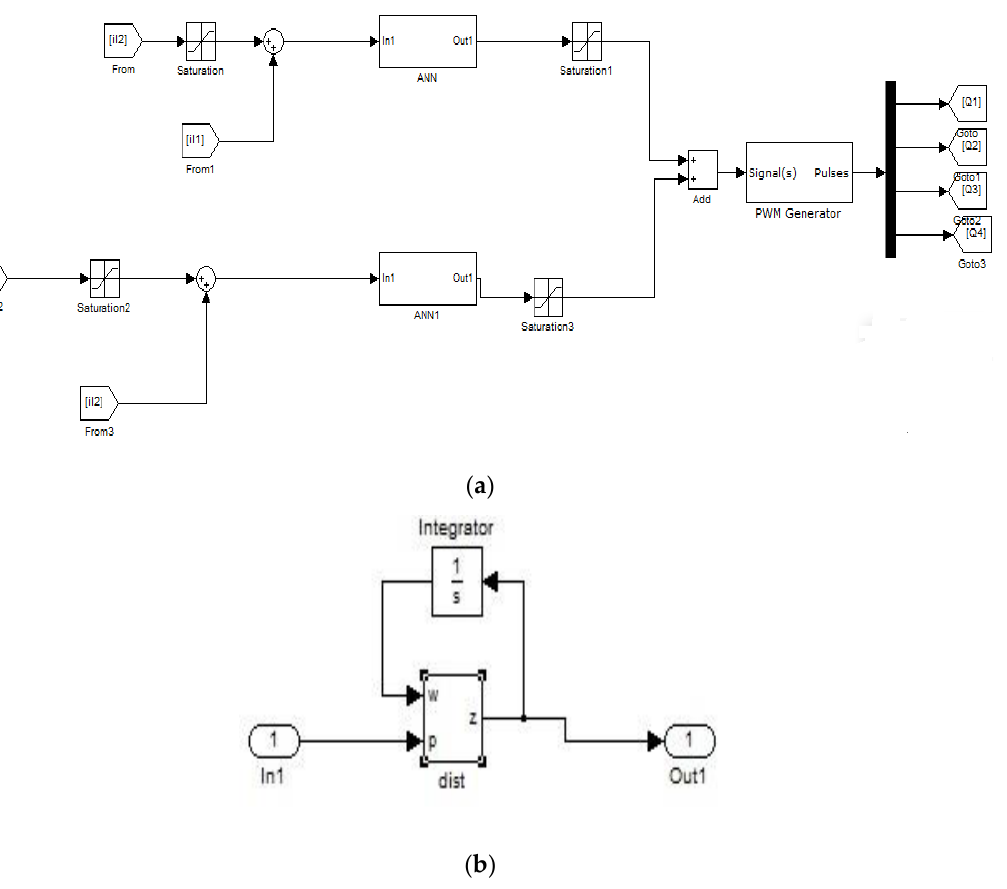
Figure 12. ( a ). Switching mechanism of ANN controller. ( b ). Euclidean distance ANN method.